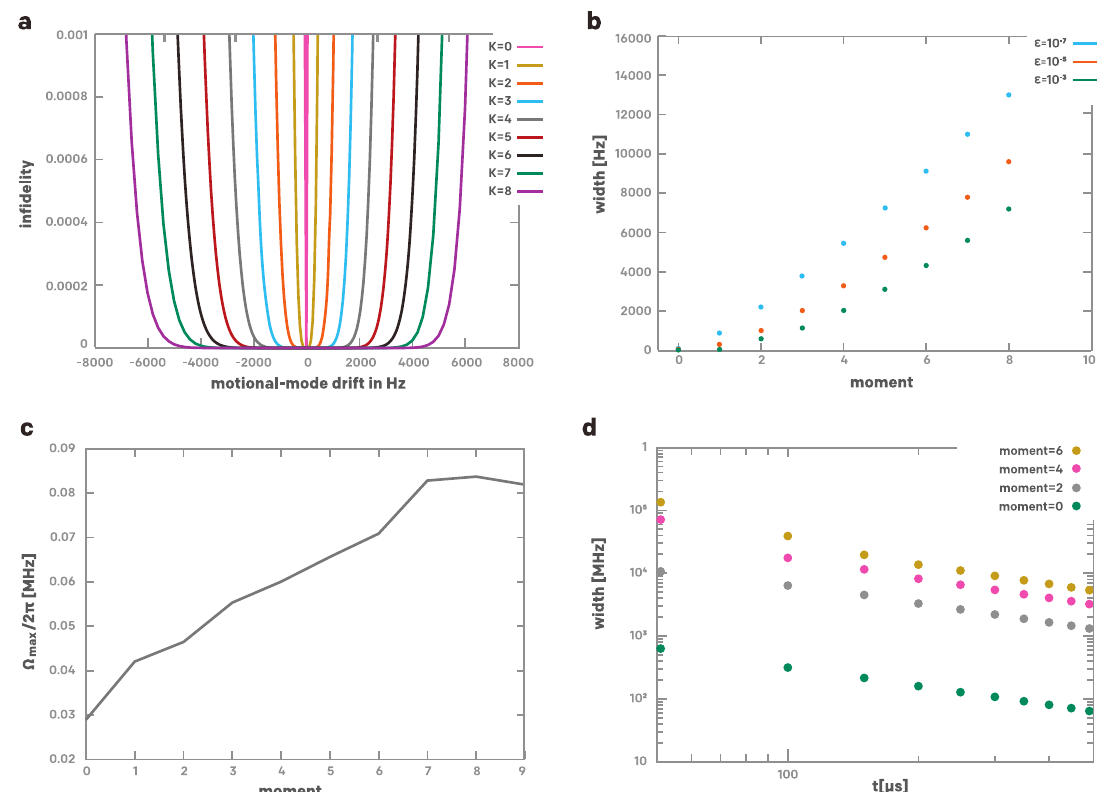
Fig. 4 Stabilization of the control pulses. a The in fi delity (see Supplementary Note 8 for detail) as a function of the motional-mode frequency drift Δ f . All mode frequencies were drifted according to ω p ↦ ω p + 2 π Δ f . b The width of the in fi delity curves in a for various error tolerances ϵ = 10 − 3 , 10 − 5 , and 10 − 7 , as a function of the highest moment K of stabilization. c The maximal power requirement max t j g the control pulses, as a function of the order or moment of stabilization K . The power requirement suggests a linear scaling in the moment of stabilization. d The width of the in fi delity curves for various different orders of stabilization K = 0, 2, 4, and 6, as a function of the gate duration τ for a fi xed error tolerance level ϵ = 10 − 3 . The data suggests ~1/ τ scaling of the